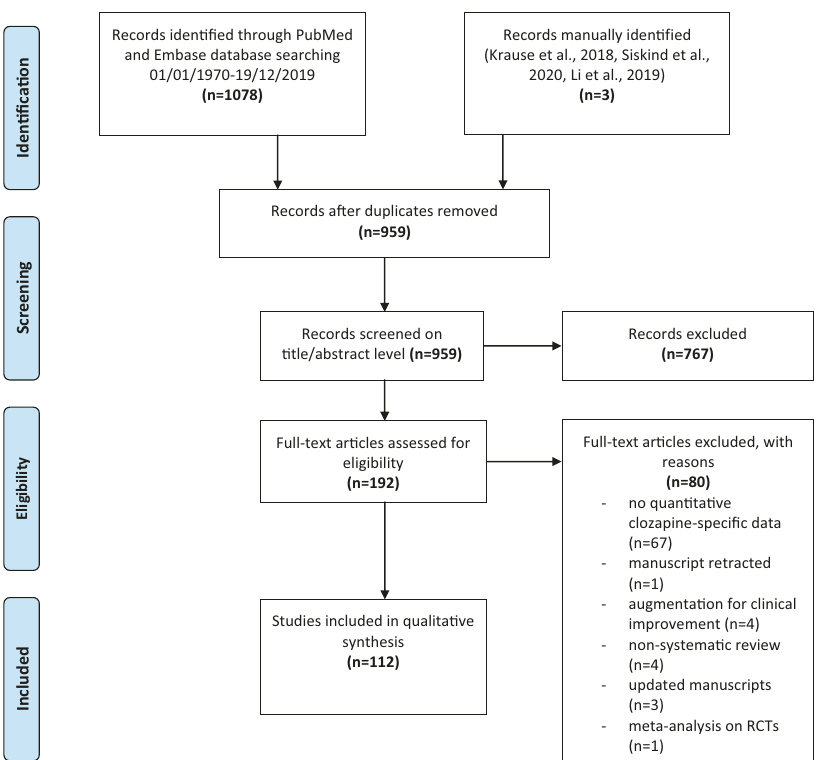
Fig. 1 Flowchart for literature search and study selection process [19]. Study selection fl ow diagram of meta-analyses providing quantitative data. Three meta-analyses were manually identi fi